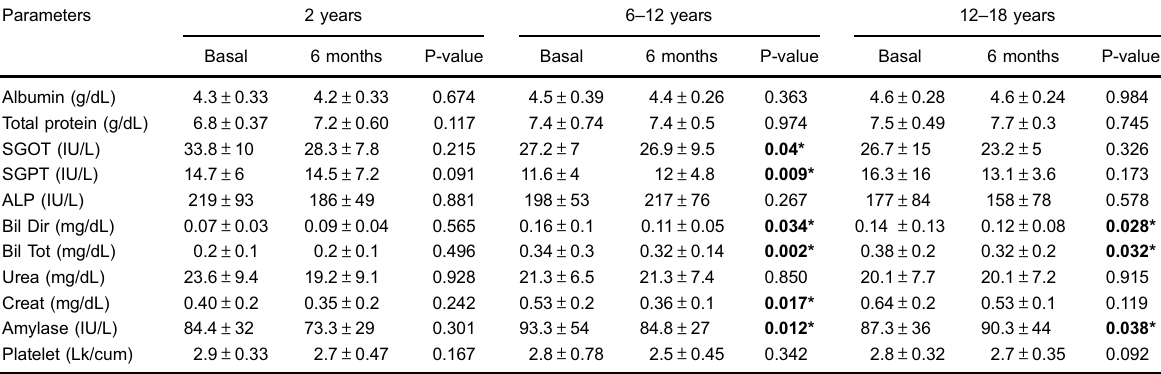
Table 5. Biochemical parameters between baseline and 6 months in the different age groups. Parameters